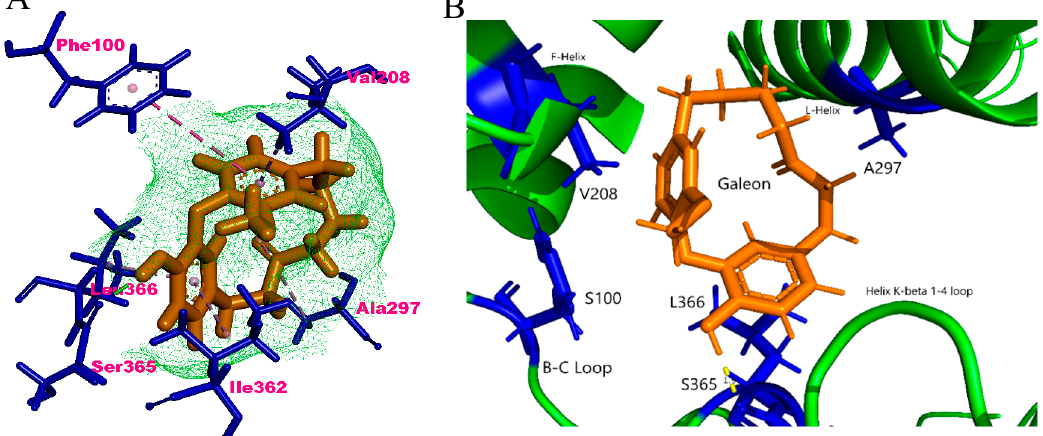
Figure 7. ( A ) 2D interaction mechanism of CYP2C19–galeon; ( B ) 3D interaction mechanism of ( A ) 2D interaction mechanism of CYP2C19-galeon; ( B ) 3D interaction mechanism CYP2C19–galeon. of